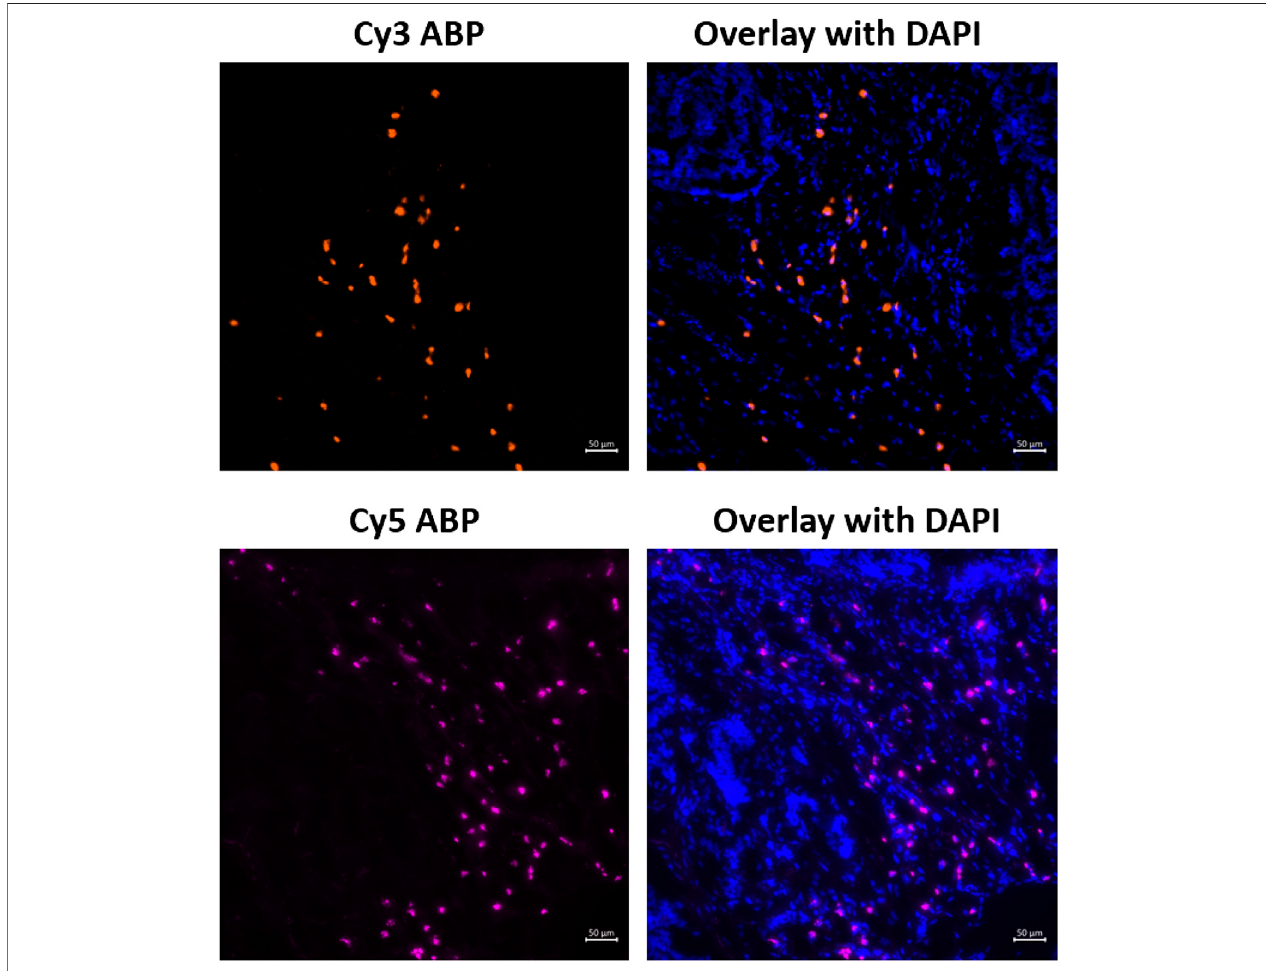
FIGURE5| StainingofactiveFAPinthetumormicroenvironmentofurothelialcancersectionsusing6(Cy3-probe)and7(Cy5-probe).Imagesarerepresentativeof at least three different tissue sections for each activity-based probe ( n (cid:2) 3).